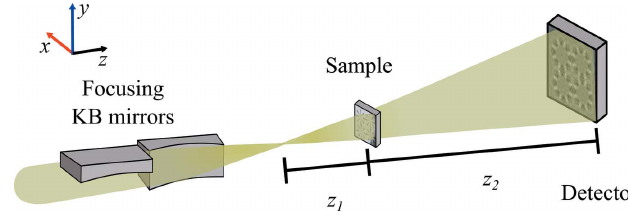
Figure 1 In-line holography. Conceptual sketch of in-line holography at the NanoMAX